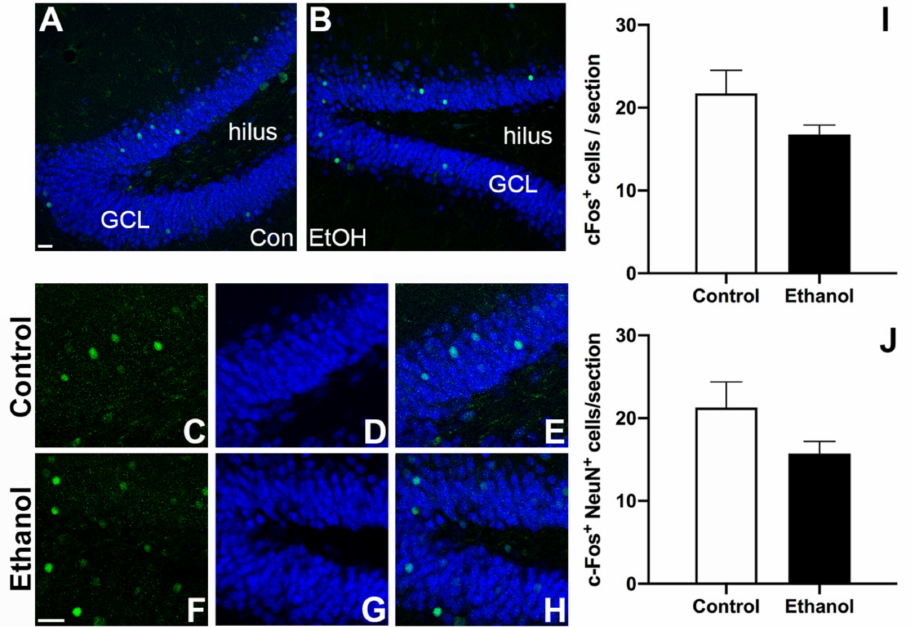
Figure 4. Neuronal activation of the Morris Water Maze (MWM) task: ( A , B ) Representative images of the dentate gyrus from control ( A ) and ethanol-exposed ( B ) animals highlighting the distribution of c- Fos/NeuN immunoreactivity. Higher magnification images for individual fluorochromes illustrating c-Fos+ alone (green), NeuN+ alone (blue), and merged for both a control ( C – E ) and an ethanol- treated ( F – H ) rat. Unpaired t -tests revealed no significant differences between the control and ethanol-exposed animals in ( I ) the number of cFos+ cells and ( J ) the number of cFos+/NeuN+ co-labelled neurons. GCL—granule cell layer. Bars represent means ± SEM. Scale bars = 40 µ